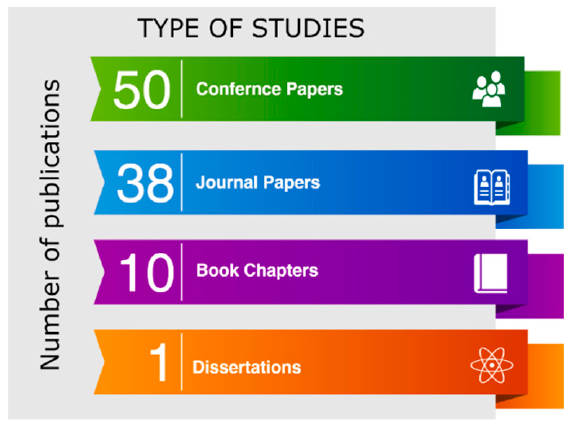
Figure 5. Number of publications per publication type.